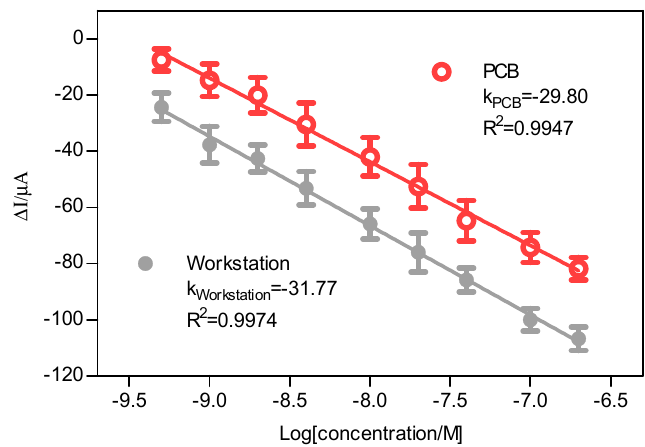
Figure A2. Calibration curves for cortisol immunosensor using smartphone-controlled DPV system (red line) and the electrochemical workstation (grey line).